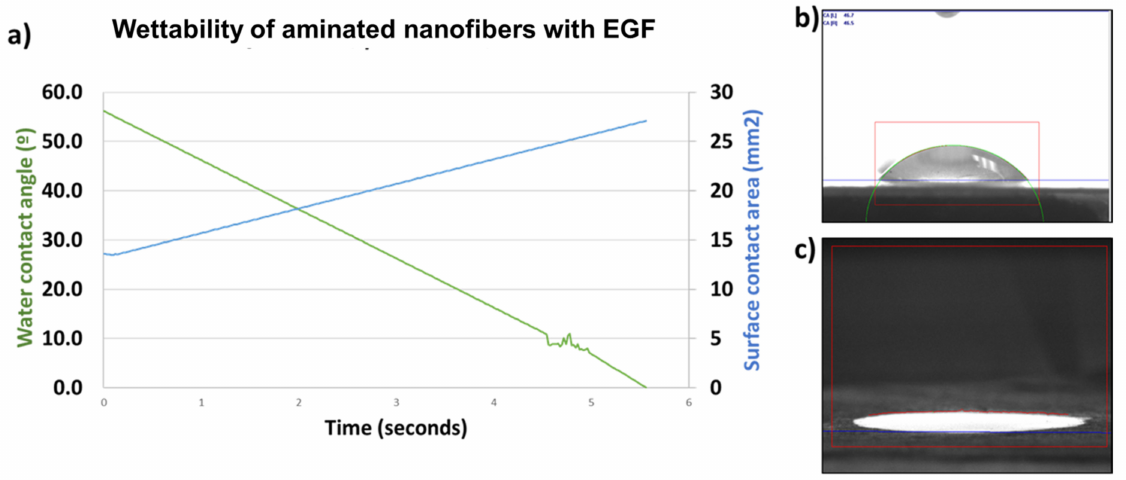
Figure 5. Wettability of aminated nanofibers with EGF. ( a ) water contact angle ( ◦ ) and surface contact area (mm 2 ) vs. time; ( b ) contact angle image (Kruss instrument on time 0 s start measurement); ( c ) contact angle image (Kruss instrument on time 5.56 s and measurement, the image is shown in color contrast to be able to observe the area generated by the